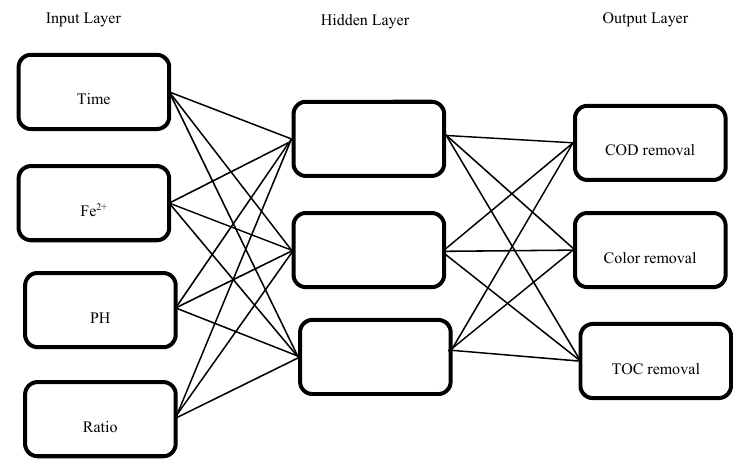
Figure 1. Schematic representation of neural network.